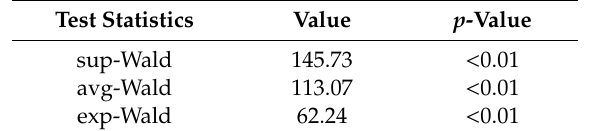
Table 3. Test for threshold effects.